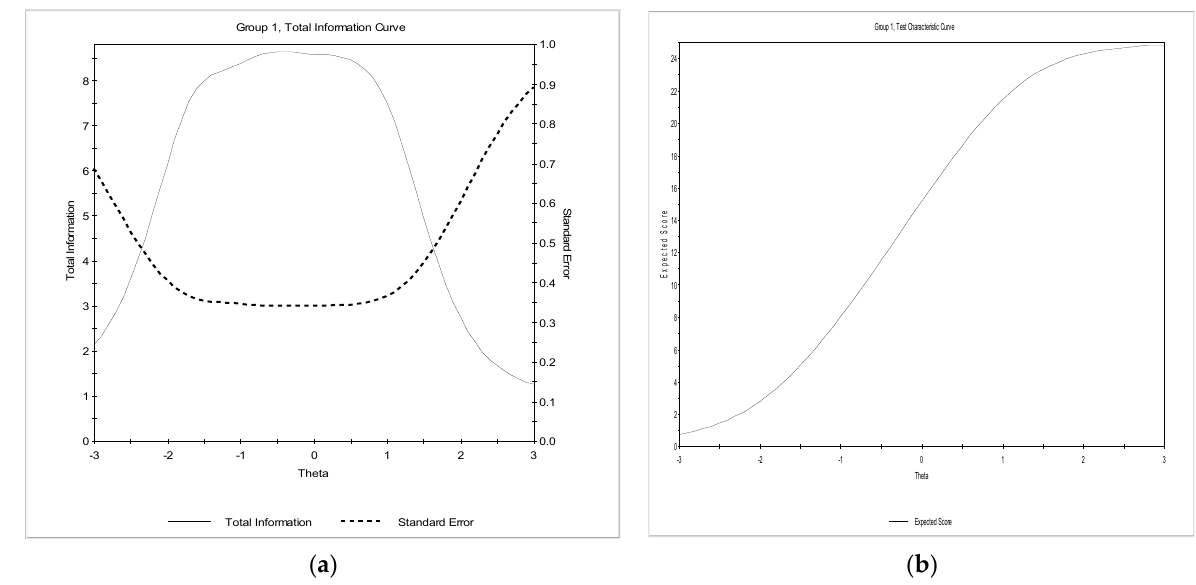
Figure 2. ( a ) Total information function ( b ) Test characteristic curve.